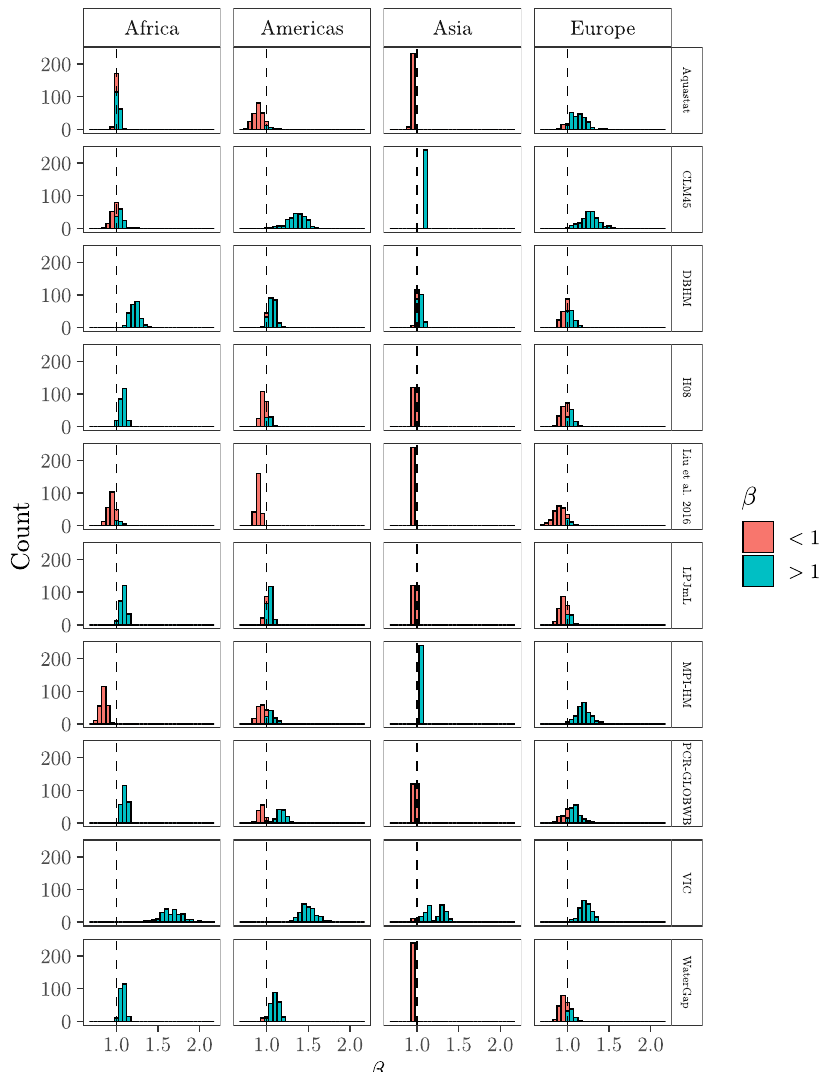
Fig. 7 Distribution of β after accounting for all the uncertainties in the computation of Eq. (1) ( X 1 , X 2 , X 3 , X 4 ). Each distribution is formed by a population of 240 β values. The histogram in the Liu et al. 16 facet for Asia consists of 17 different yet very similar β values and hence its single bin. The vertical, dashed line is at β = 1 (see